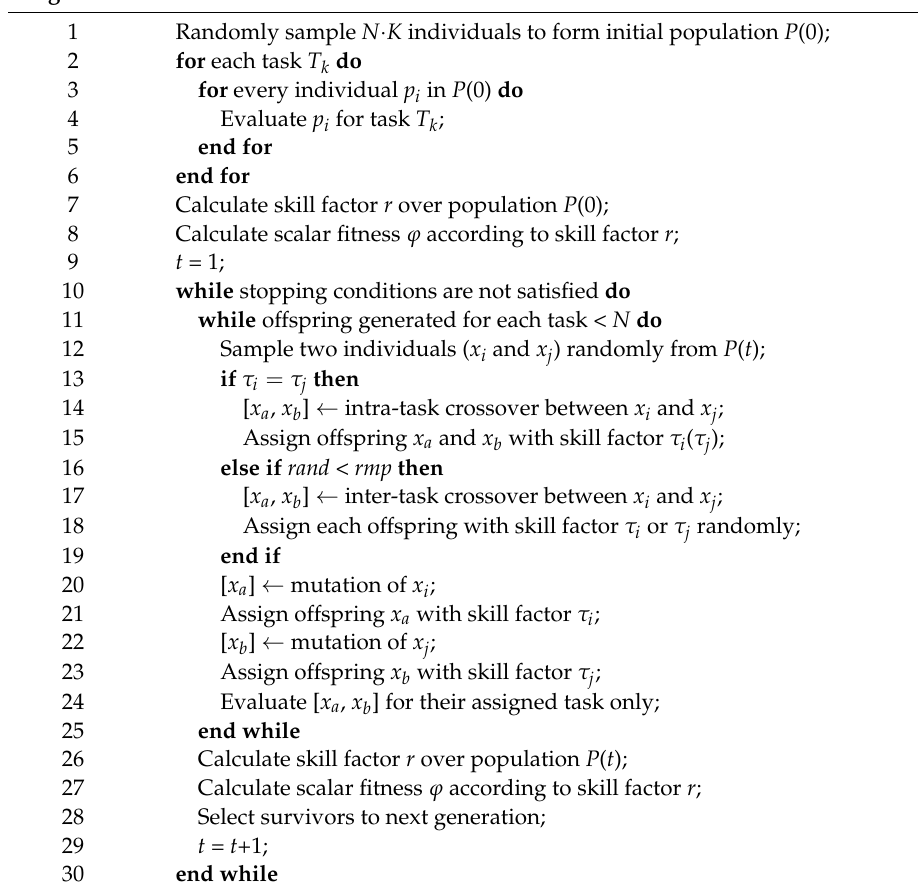
Algorithm 1 Basic Structure of the Canonical MFEA